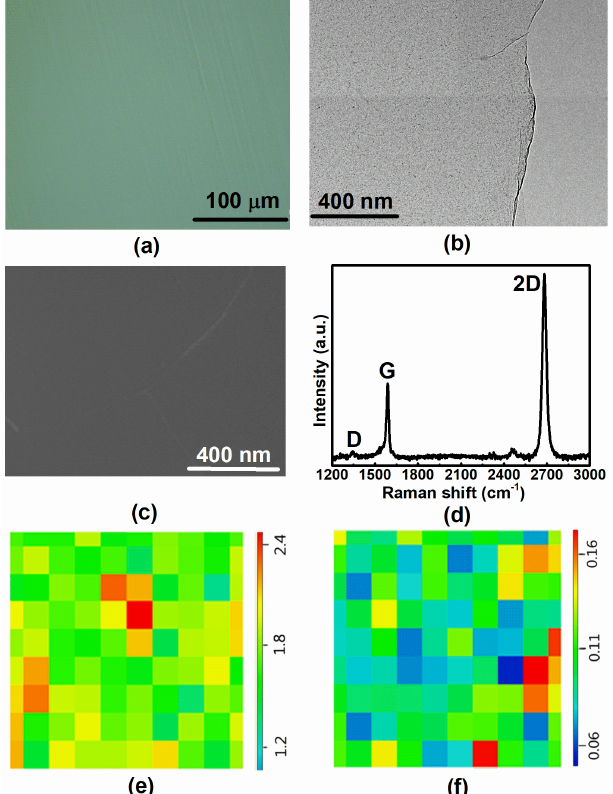
Figure 2. ( a ) The optical image of the surface of the electropolished copper foil. ( b ) The TEM image of the boron-doped graphene on the copper grid. ( c ) The SEM image of the boron-doped graphene on the silicon substrate with a 300-nm oxide layer. ( d ) The Raman spectrum of the boron-doped graphene on the silicon substrate with a 300-nm oxide layer. The Raman mapping of the I 2D /I G value ( e ) and I D /I G value ( f ) of the boron-doped graphene grown on the electropolished copper foil in an area of 20 × 20 μ m 2 .